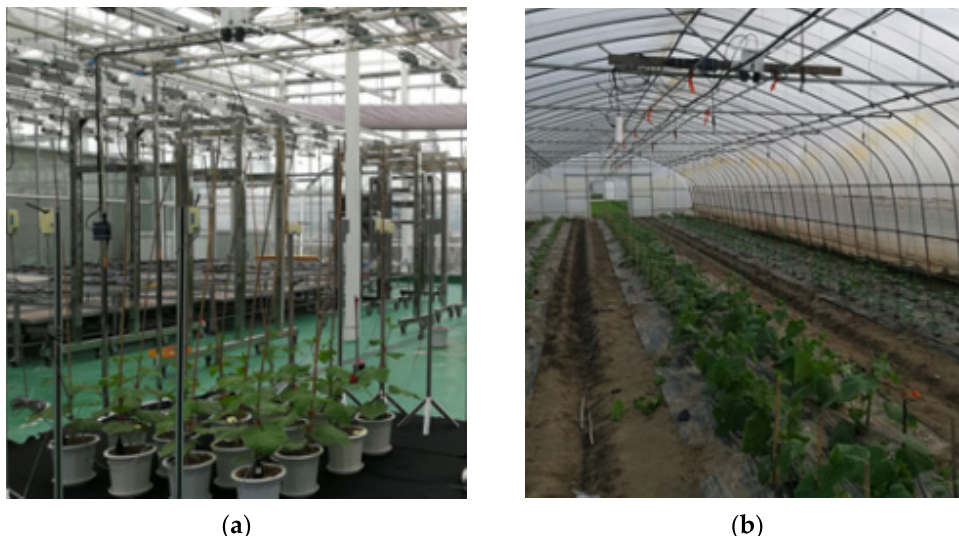
Figure 4. Image acquisition scene: ( a ) in glass greenhouse; ( b ) in plastic greenhouse.